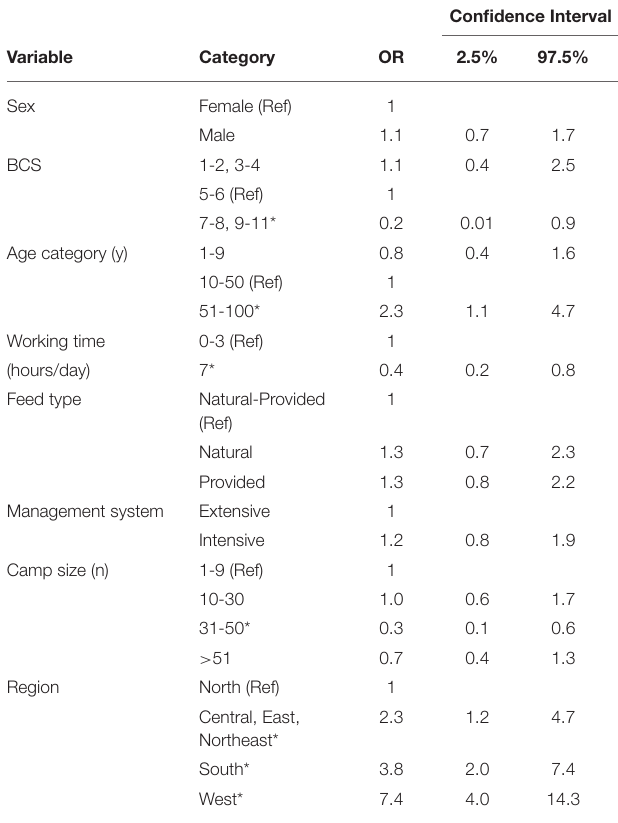
TABLE 4 | Number of positive serological tests (out of 4) done (ESAT6, CFP10, MPB83 and TB Stat-Pak) of elephant samples vs. the predicted TB serology test outcome based on latent class analysis.